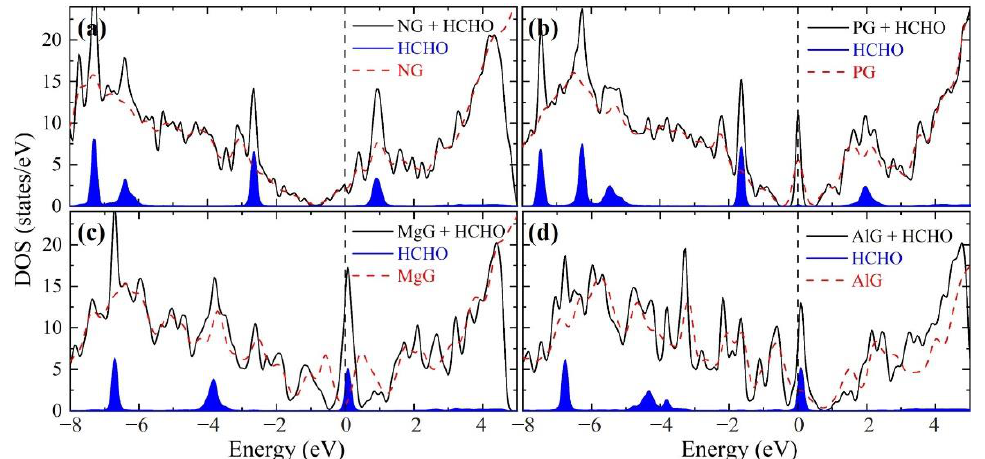
Figure 4. Total and projected densities of states for the ( a ) N-doped graphene (NG), ( b ) P-doped graphene (PG), ( c ) Mg-doped graphene (MgG), and ( d ) Al-doped graphene (AlG) systems with HCHO adsorption. The black and red dashed lines indicate total DOS of X-doped graphene with and without HCHO adsorption. The blue region represents the projected DOS of the adsorption HCHO molecule. The Fermi level is shifted to zero and represented by vertical dashed lines.